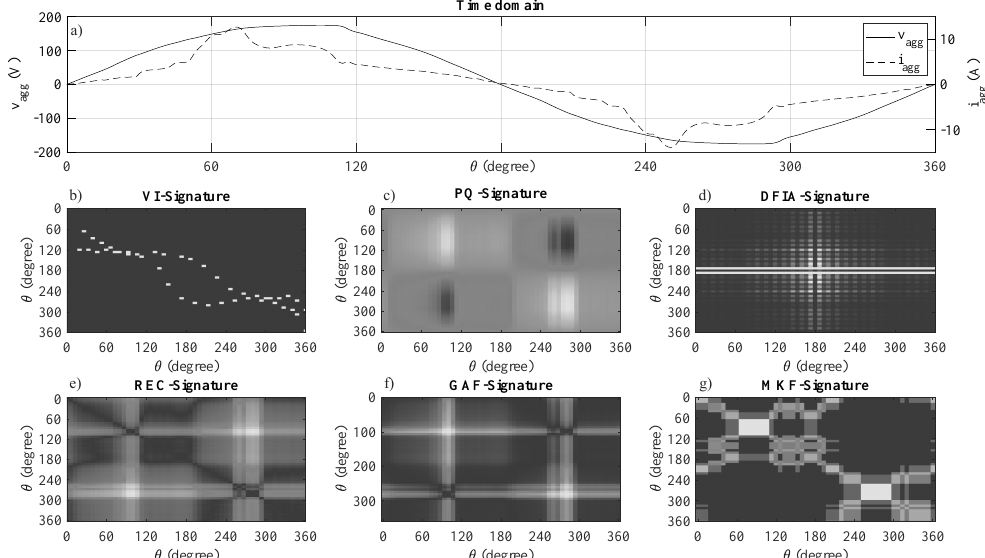
Figure 1. One electrical cycle for the aggregated current and voltage ( a ) as well as the transformed signals as obtained from the time series imaging ( b – g